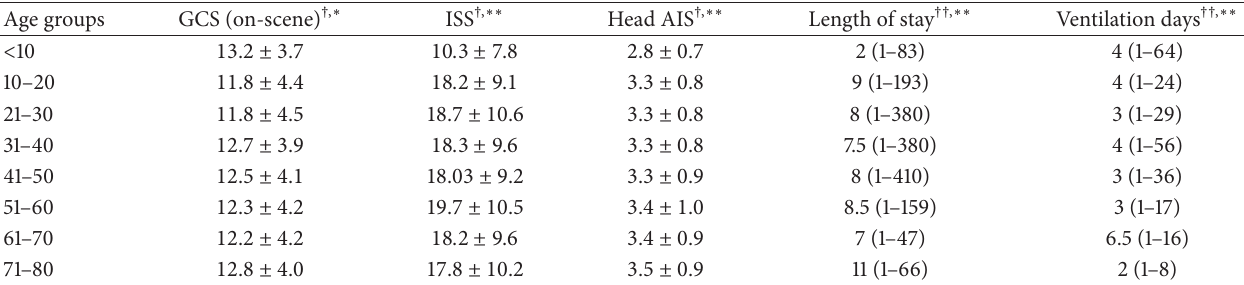
Table 4: Characteristics of patients of different age groups based on the injury severity, length of hospital stay and ventilator days. Age